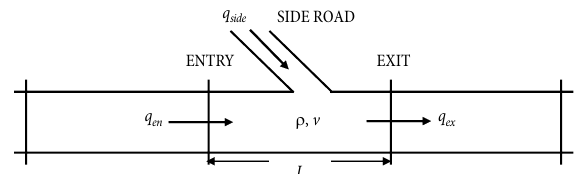
Fig. 1. Schematic diagram of a typical road